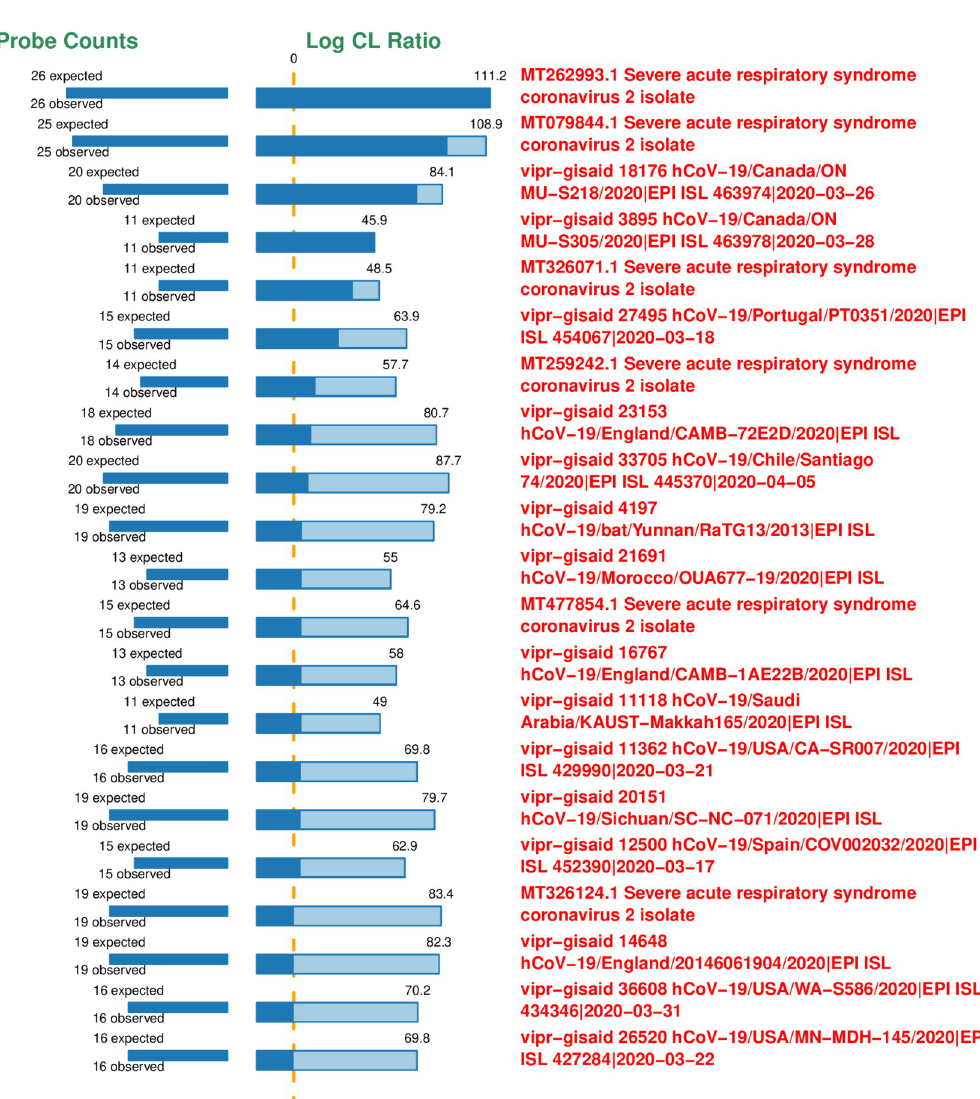
Fig 1. LLMDA result of synthetic SARS-CoV-2 RNA control (Twist Bioscience). The array was analyzed using the 99% threshold of signal above random controls. The light and dark colored portions of the bars represent the unconditional and conditional log-odds scores, respectively. The conditional log-odds scores show the contribution from a target that cannot be explained by another, more likely target above it. The unconditional score illustrates that some very similar targets share a number of